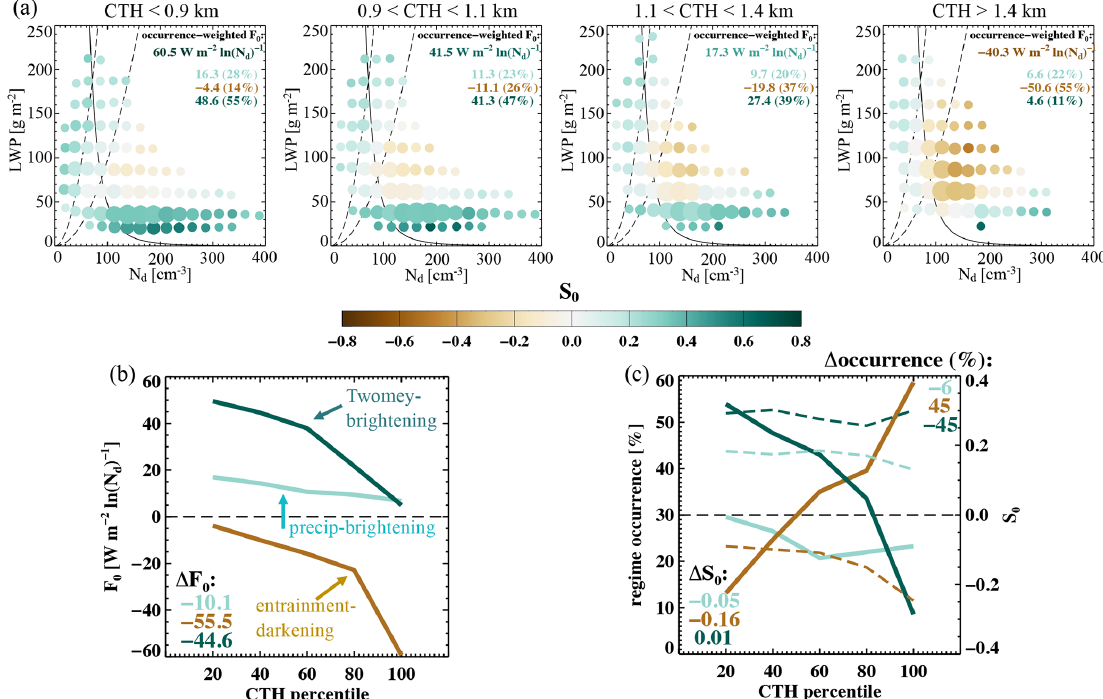
Figure 6. (a) As in Fig. 3 but conditioned on cloud-top height (CTH) quartiles. Occurrence-weighted mean (b) F 0 and (c) regime-mean S 0 (dashed curves) and regime–occurrence (solid curves) of the three albedo susceptibility regimes (defined in Fig. 3) as a function of CTH; increment of 20th percentile.